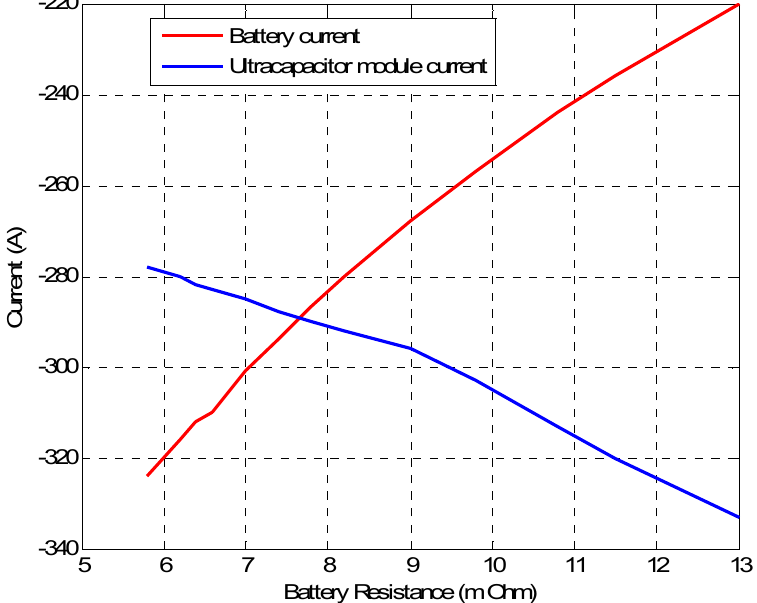
Figure 9. Cranking current sharing as a function of ultracapacitor branch resistance keeping battery branch resistance constant.